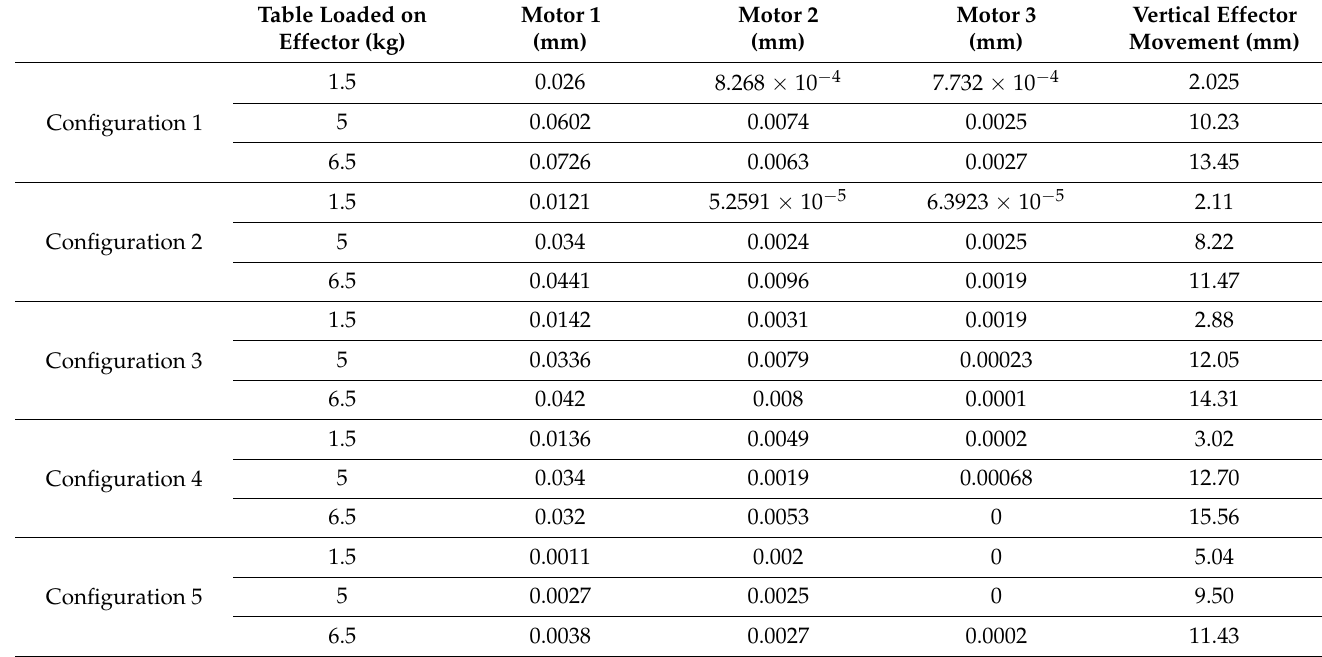
Table 4. Experimentally determined values of axial displacements in linear motors, and the vertical displacement of the effector, for the five configurations, after applying the masses to the